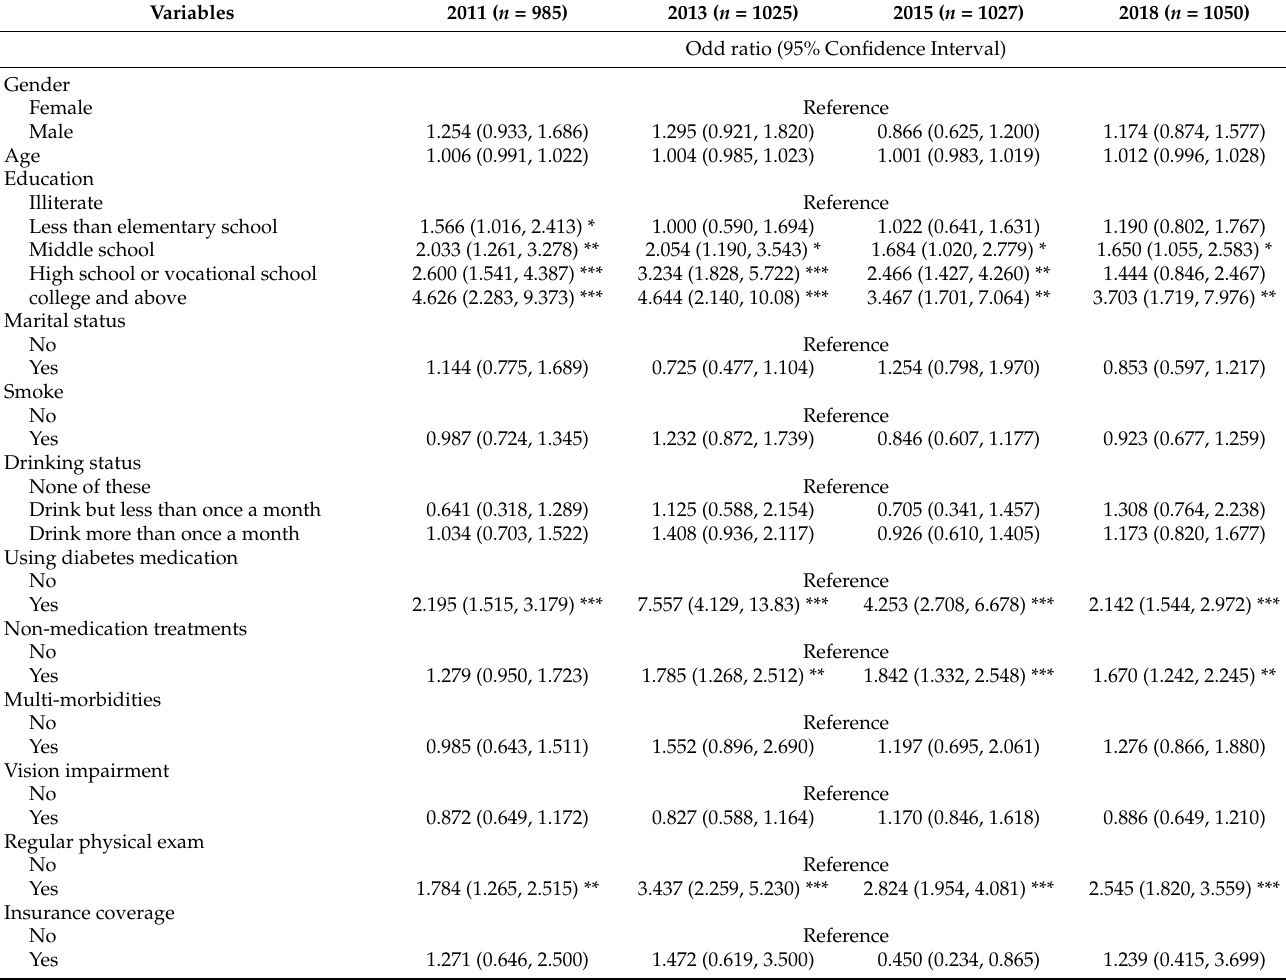
Table 2. Univariate logistic regression of factors associated with adherence to annual fundus exam.